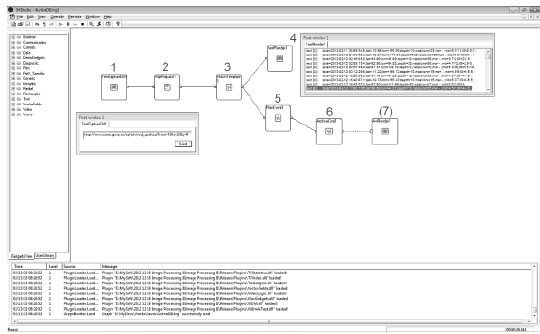
Figure 5. Event-driven IS prototyped on SH